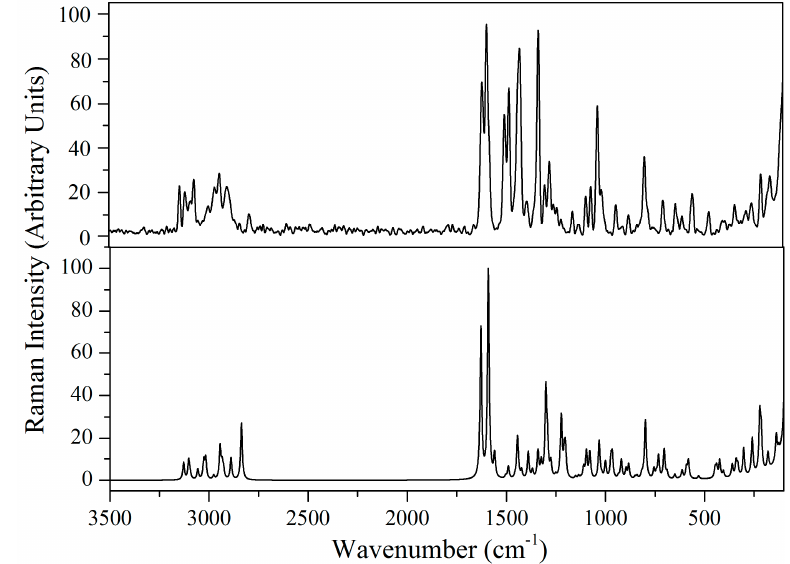
Figure 4. Experimental ( upper ) and simulated ( lower ) FT-Raman spectra of compound 4 .